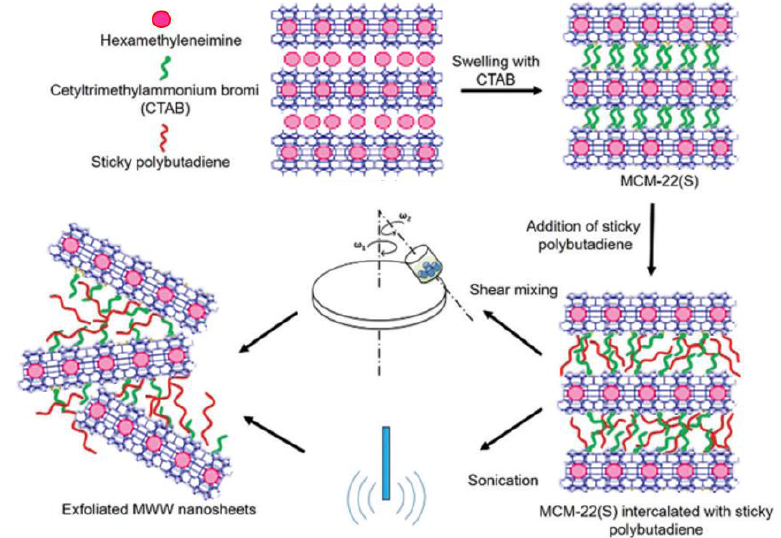
Figure 6. Scheme of the formation of delaminated MWW-type material using telechelic liquid polybutadienes. Adapted from Reference [57]. Copyright (2017), with permission of The Royal Society of Chemistry.